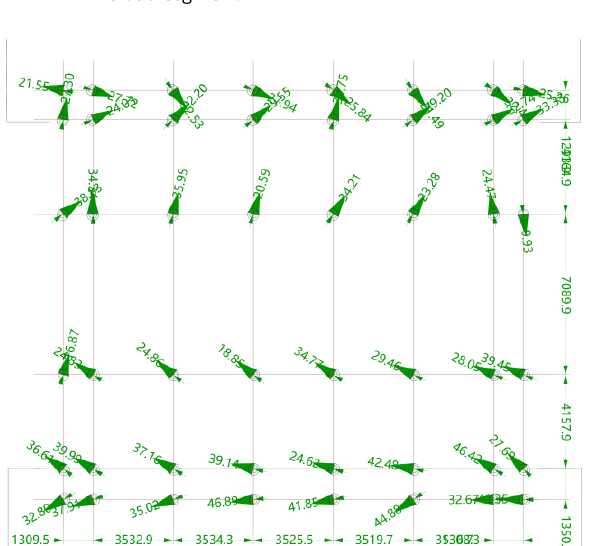
Figure 12. Grid system generated for the Main Hall of Jingfu Palace, Forbidden City (the Place Museum), Beijing